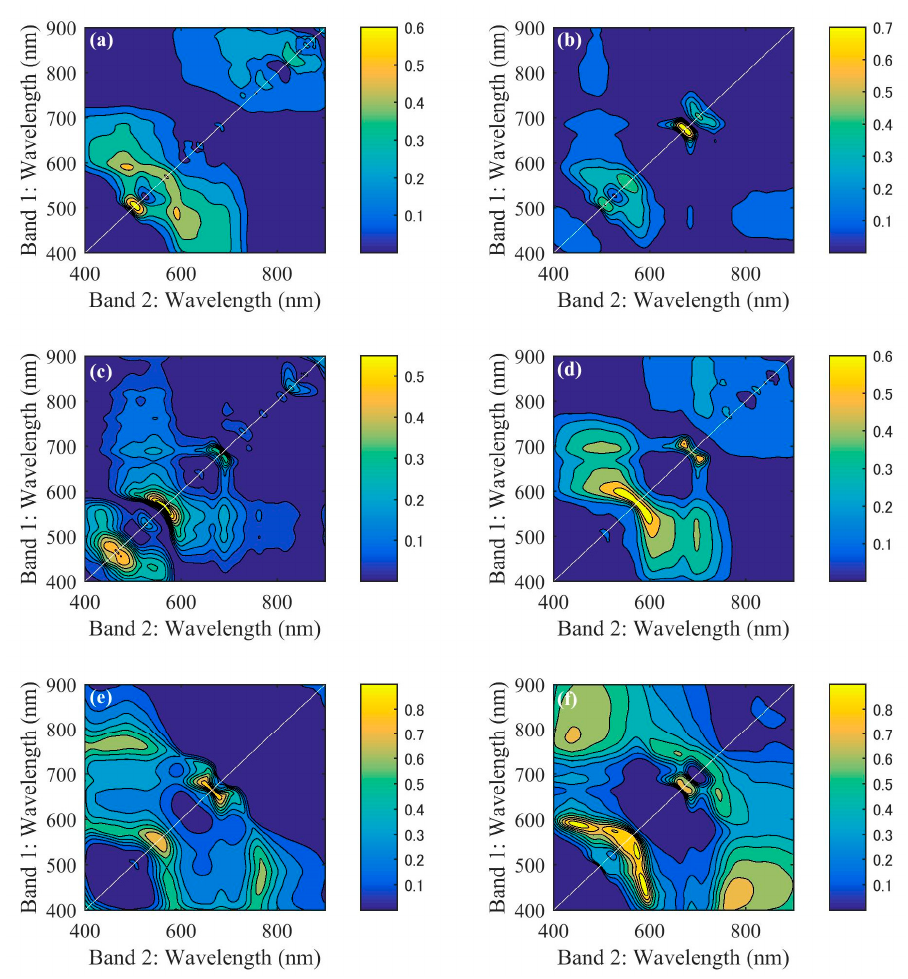
Figure 8. Two-dimensional R 2 distributions obtained through sequential regressions using all band ratios and chlorophyll a (Chl- a ) concentrations for each station (( a – f ) are stations 1 to 6 in turn).